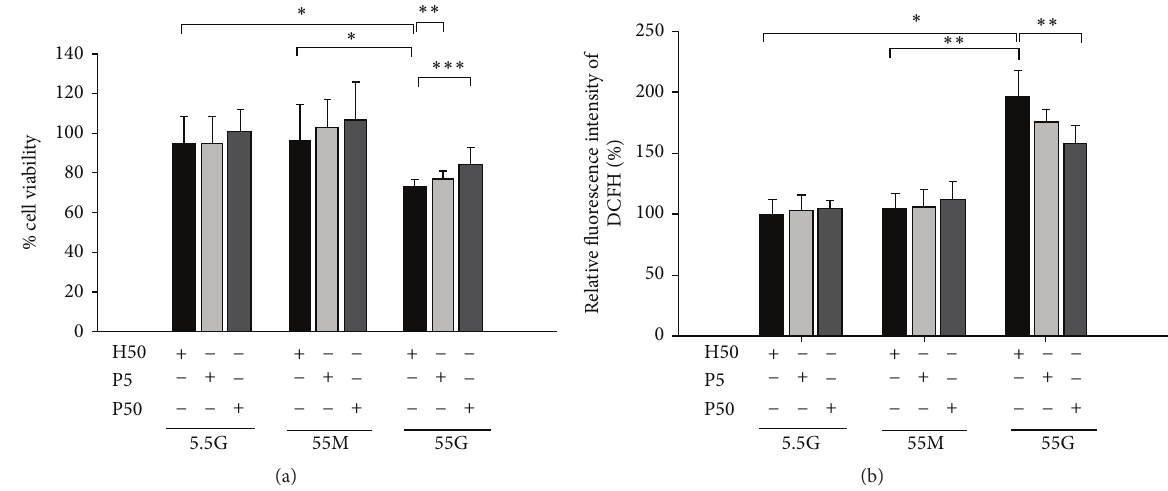
Figure 1: Effect of propolis on the viability and ROS production of cultured RLECs. Effect of propolis on intracellular ROS production and survival of RLECs following high glucose stress. Honey (50 𝜇 g/mL; H50) or propolis (5 or 50 𝜇 g/mL; P5 or P50) was added to RLECs cultured with 5.5 or 55 mM D-glucose or with 55 mM D-mannitol as osmotic control; 120hrs later, ROS levels were measured using H2-DCFH-DA assay (a) and cell viability was estimated using colorimetric MTS assay (b). Results shown are the mean ± SD of three experiments. Asterisks denote statistically significant differences. (a) ∗ 𝑃 < 0.009 , ∗∗ 𝑃 < 0.05 , and ∗∗∗ 𝑃 < 0.002 . (b) ∗ 𝑃 < 0.0000001 and ∗∗ 𝑃 < 0.04 .